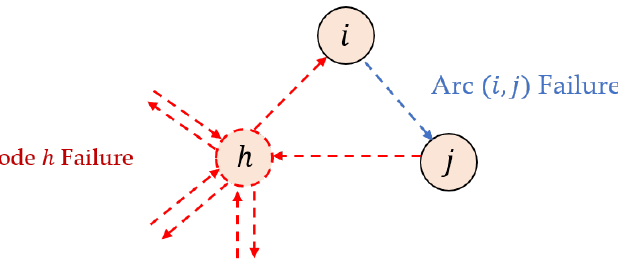
Figure 4. Illustration of the two types of failure in the KEP graph.